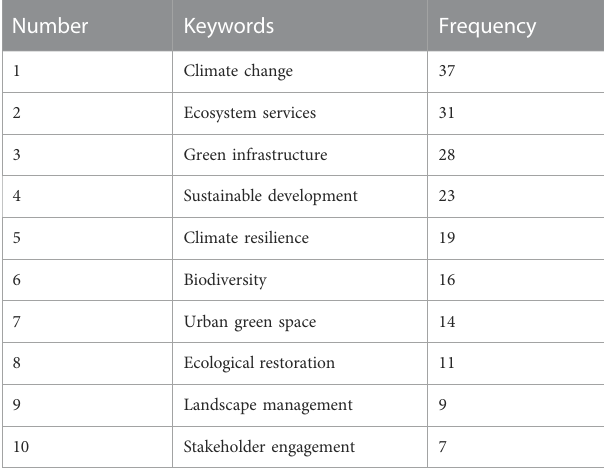
TABLE 1 Top ten high-frequency emergent words.